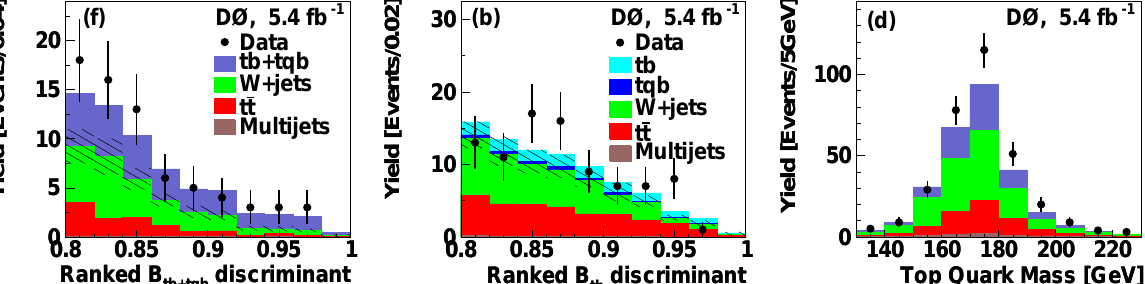
Fig. 6. Distributions of the s + t discriminant (left) and s discriminant (middle) in the signal region [0.8, 1] and distribution of the reconstructed top quark mass in a data sample with S / B > 0 . 24 (right).